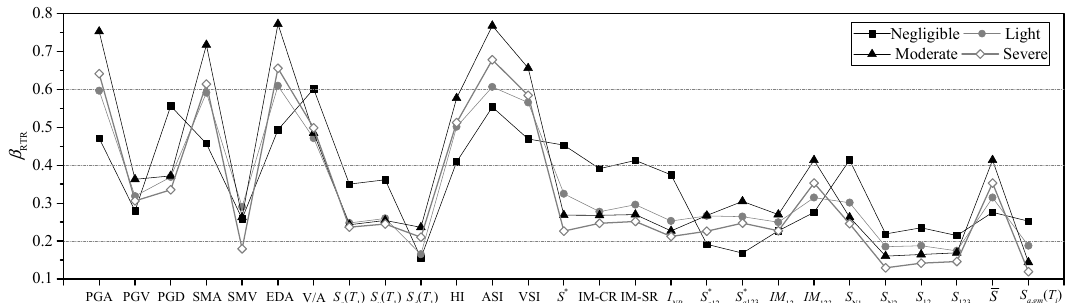
Figure 8. β RTR estimated at different limit states under far-field ground motions.